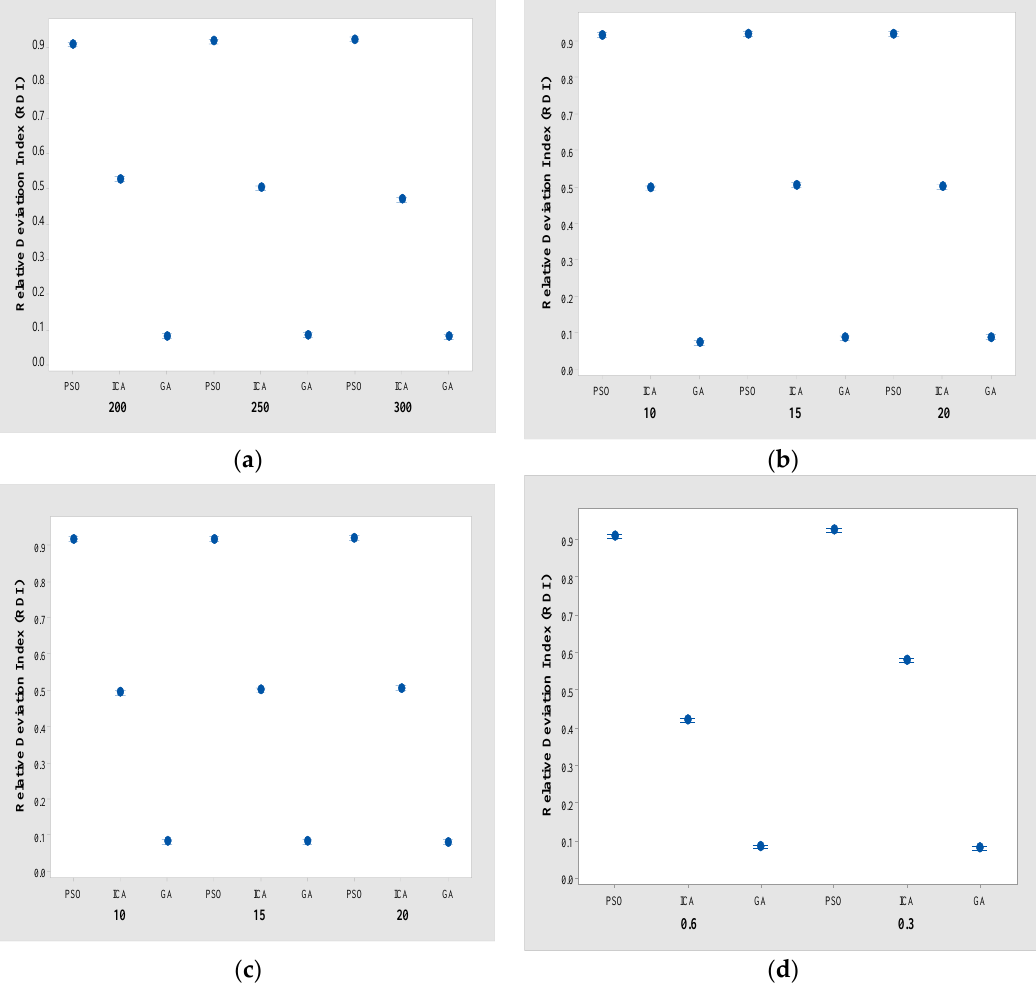
Figure 6. The mean plots and Tukey HSD intervals (α = 0.05) for PSO, ICA, and GA. Figure 7 shows the mean plots and Tukey HSD intervals (α = 0.05) for |𝐽| , |𝑇| , |𝐶| , and δ groups. For |𝐽| , |𝑇| , |𝐶| , and δ groups, the performance is ranked in the order of GA, ICA, and PSO, and the difference in RDI between PSO, ICA, and GA is statistically significant. In particular, GA provides the best RDI and robustness among all algorithms.